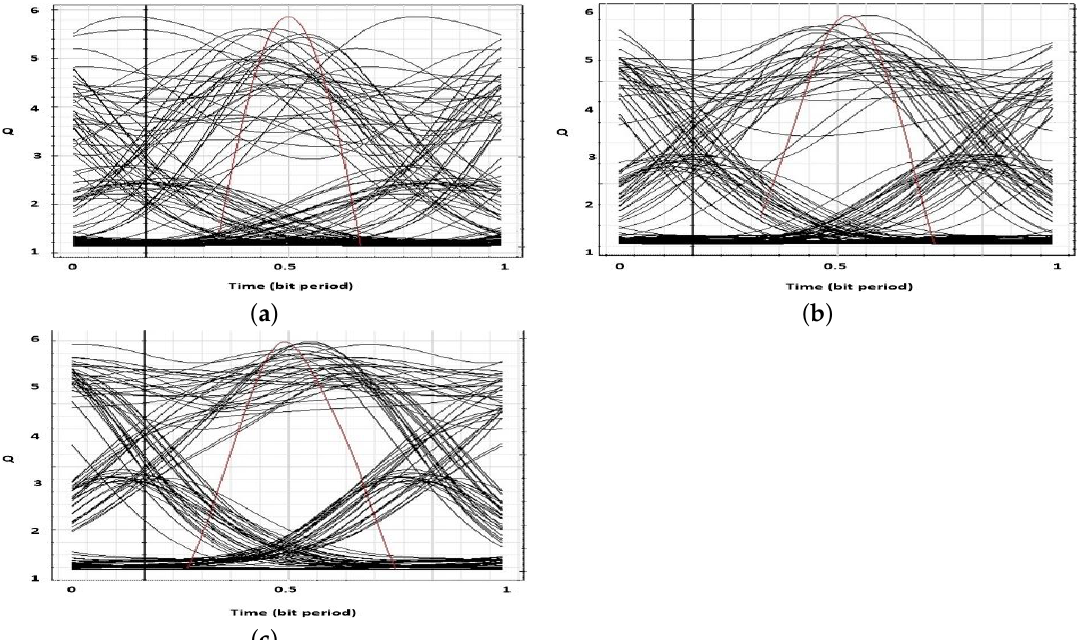
Figure 9. BER eye-diagrams. ( a ) Distorted eye diagram when no technique is applied for compensating NLs, LDs, and phase noise at 61 GHz RF waves and 20 km of transmission path cover. ( b ) Distorted eye diagram when no technique is applied for compensating NLs, LDs, and phase noise at 57 GHz RF waves and 10 km of transmission path cover. ( c ) Eye diagram of the NL-, LD-, and phase-noise-compensated RoF model at 61 GHz RF waves and a 20 km fiber